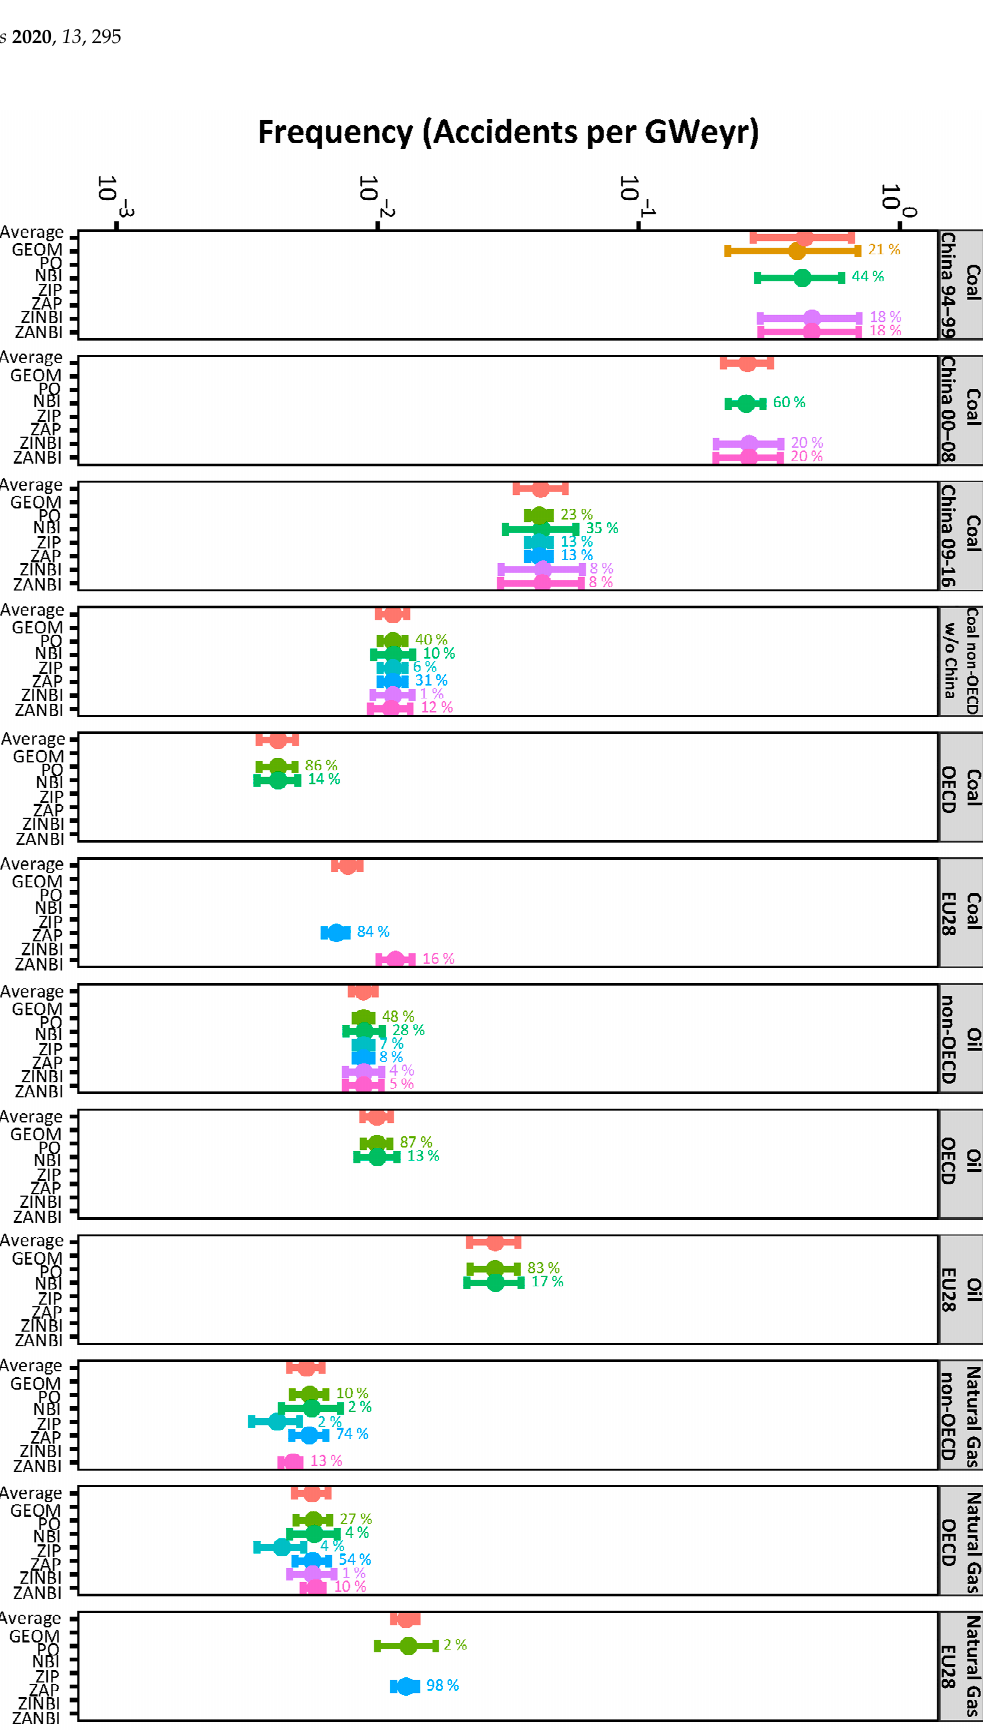
Figure 1. For each energy chain and country group combination, normalized accident frequencies are reported for the selected set of distributions as well as the Bayesian Model Averaging (BMA) (Average), including mean, 5% and 95% quantiles, and percent contributions (weights).